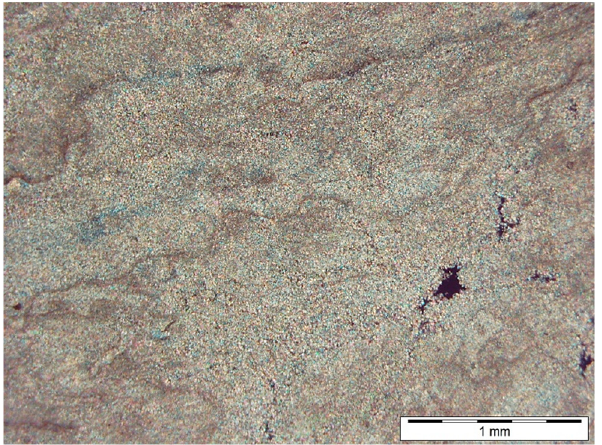
Figure 4. Magnesite from the Braszowice deposit, showing irregular lamination and empty pores.